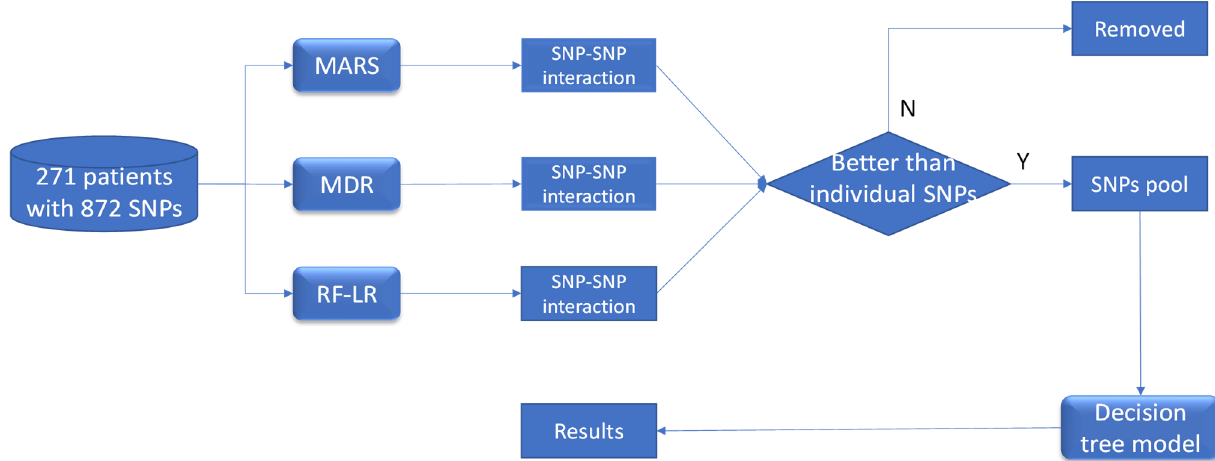
Figure 1. The diagram of the working flow to identify SNP–SNP interaction as a potential risk factor for chronic drug- induced liver injury. Specifically, multivariate adaptive regression spline (MARS), multifactor dimensionality reduction (MDR) and Random Forest plus logistic regression (RF-LR) were used to identify the SNP–SNP interaction terms linked to chronic DILI. Only the SNP–SNP interactions which had better association with DILI chronicity than individual SNPs were kept. All these SNPs of the selected interactions were pooled together as the candidate predictors, and a decision tree model is developed using classification and regression trees algorithm.